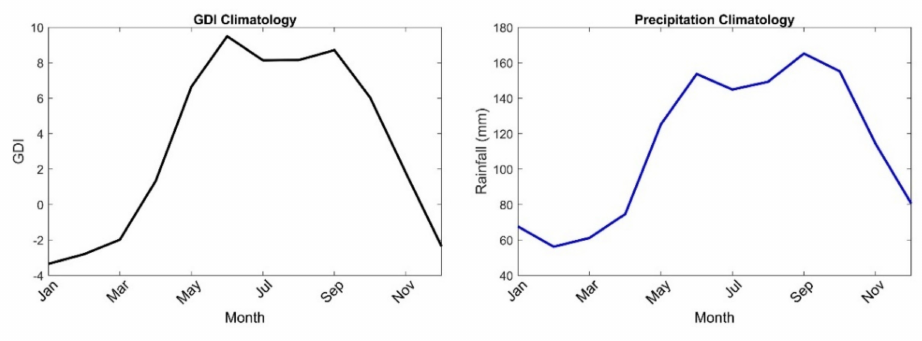
Figure 5. The Galvez-Davidson Index (GDI) annual climatology ( left ) and the precipitation annual climatology ( right ) for the Caribbean and surrounding region (5 ◦ –31 ◦ N, 100 ◦ W–55 ◦ W), also referred to as the Intra-Americas Region (IAR), for base period